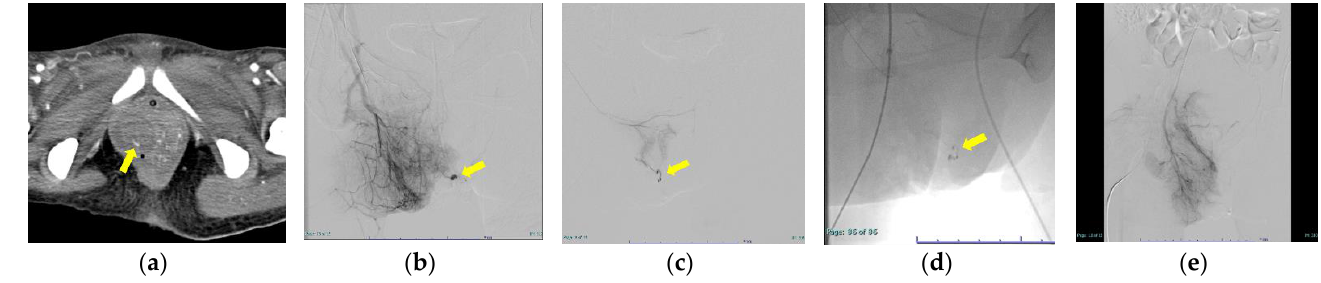
Figure 2. The procedure for using NBCA (in Case 5). ( a ) Contrast enhanced-CT arterial phase. (Arrow) A linear shadow and hematoma were found on the right side of the vaginal wall, and arterial bleeding was suspected. ( b ) Right pudendal arteriography. (Arrow) Extravasation was observed in the vaginal branch. ( c ) (Arrow) Extravasation was observed from the peripheral branch of the internal pudendal artery. ( d ) Since the catheter could be advanced to the vicinity of the bleeding point, embolization was performed with NBCA diluted solution (NBCA:lipiodol = 1:4). The arrow is an image of NBCA accumulating at the bleeding point. ( e ) Inferior gluteal angiography. Disappearance of extravasation image.